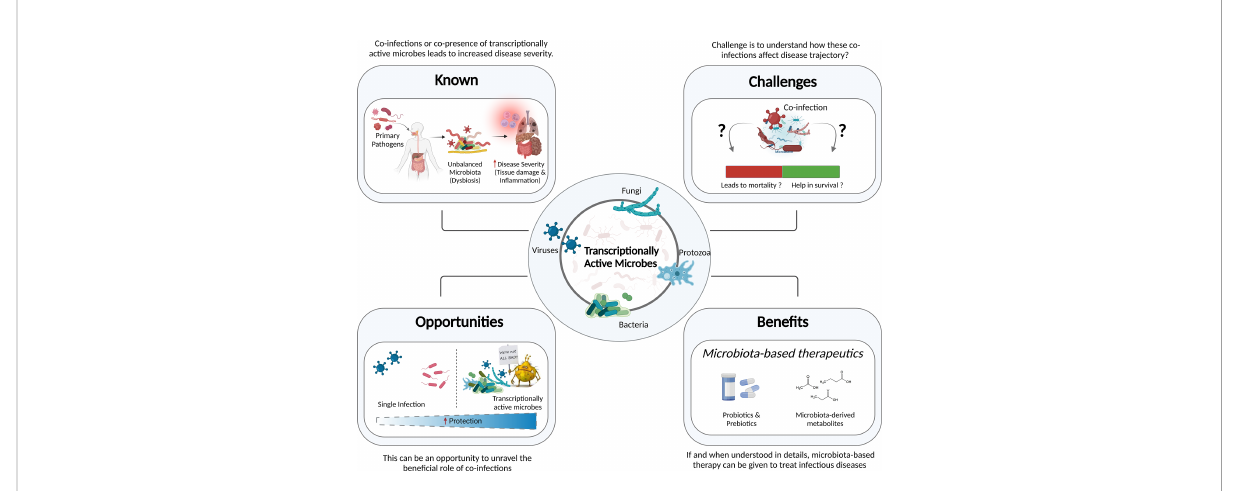
FIGURE 5 Information to Knowledge. Understanding the known, overcoming the challenges, transforming them into opportunities, and reaping the bene fi ts of this knowledge - in public health and clinical decision making - will augment future pandemic